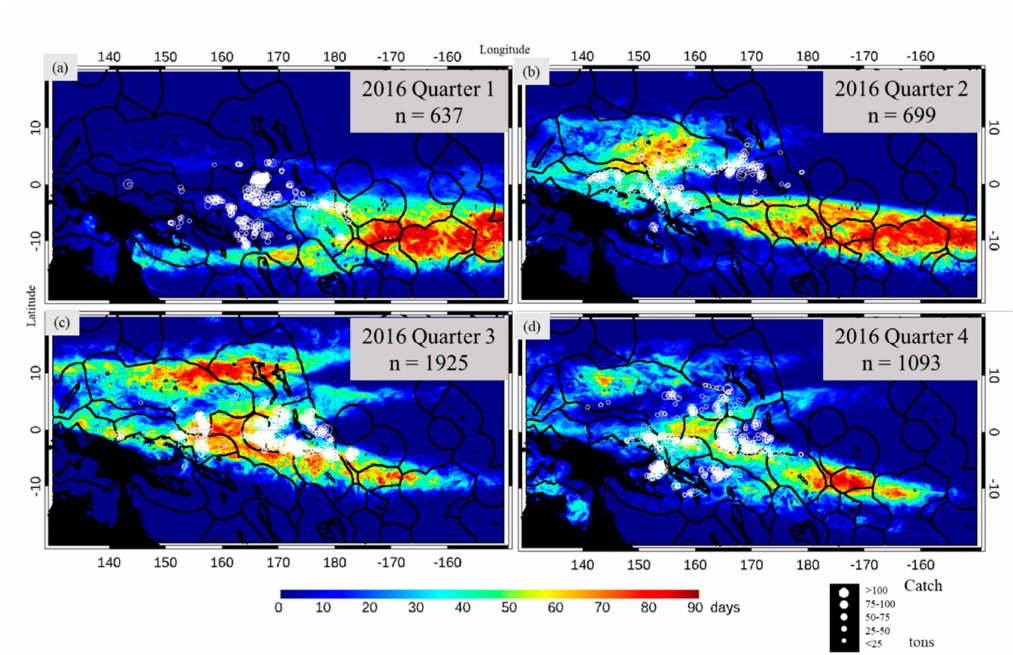
Figure 6. Fishing spots of Taiwanese operational vessels with habitat variation: ( a ) quarter 1, ( b ) quarter 2, ( c ) quarter 3, and ( d ) quarter 4 in 2016.